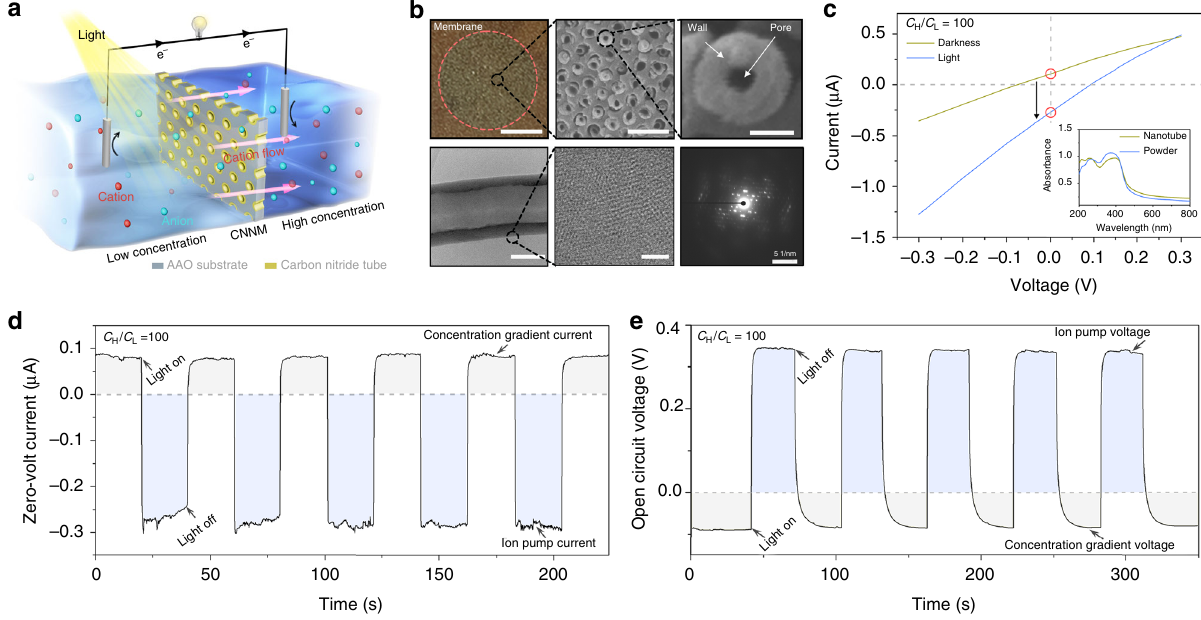
Fig. 1 Light-induced ion pump based on carbon nitride nanotube membrane. a Schematic of the light-induced ion pump, which can pump ions transport against a concentration gradient. b Optical image (scale bar 0.2 cm), SEM image (scale bar 500 nm) of CNNM, and typical opening view of nanotube (scale bar 50 nm). The TEM images of a single nanotube (scale bar 50 nm), the enlarged crystalline pore wall section (scale bar 5 nm), and electron diffraction. c The typical current – voltage curves before and after light (143 mW/cm 2 ) irradiation at 100-fold ( C H = 0.01 M; C L = 0.0001 M) KCl concentration gradient. After irradiation, the zero-volt current changed from positive to negative value. The inset shows the light absorbance of carbon nitride nanotube and powder. d Measured cyclic constant zero-volt current with the alternating illumination at 100-fold KCl concentration gradient. e Measured open-circuit voltage across the CNNM before and after illumination in 100-fold KCl concentration